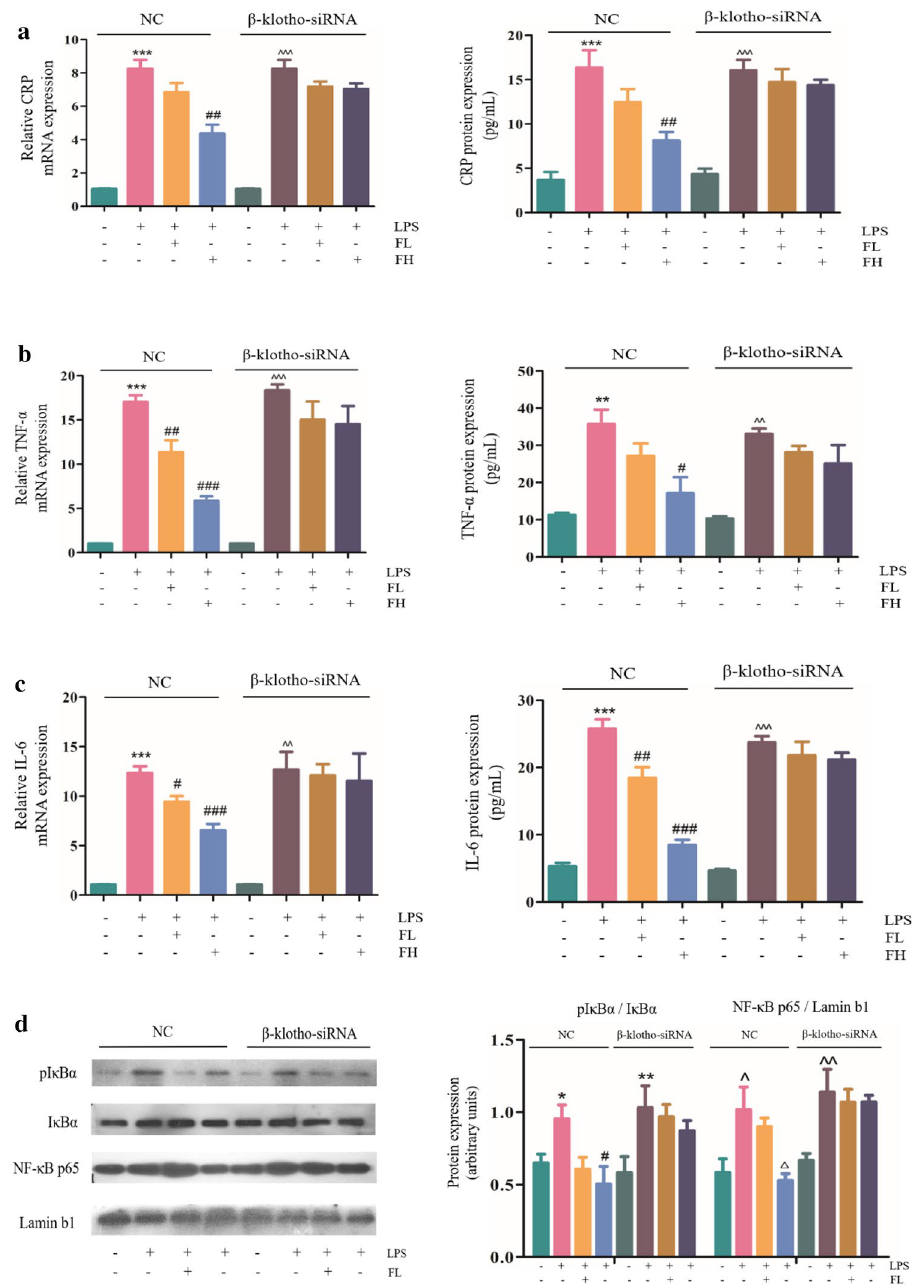
Figure 5. FGF-21 inhibits the expression of inflammatory cytokines in EA.hy926 cells. β-klotho-siRNA or NC siRNA was transiently transfected into EA.hy926 cells using Lipofectamine 3000 transfection reagent. Cells were treated with LPS (1000 μg/mL) with or without FGF-21 (FL: FGF-21 0.1 M, FH: FGF-21 1.0 M). CRP: C-reactive protein; TNF-α: tumor necrosis factor-α; IL-6: interleukin 6; NC: nontransfection. ( a - c ) Analysis of CRP, TNF- α, IL-6 expression in EA.hy926 cells by real-time PCR and ELISA. ( d ) Western blot analysis of phospho-IκB and p65 expression in EA.hy926 cells. For all bar graphs, data are expressed as the mean±SD (n = 3). One-way ANOVA was used for multiple group comparisons, followed by Student’s two-tailed t test. * p < 0.05, ** p < 0.01, *** p < 0.001 compared with the control NC group; # P < 0.05, ## P < 0.01, ### P < 0.001 compared with the model NC group; ^ P < 0.05, ^^ P < 0.01, ^^^ P < 0.001 compared with the control of β-klotho-siRNA